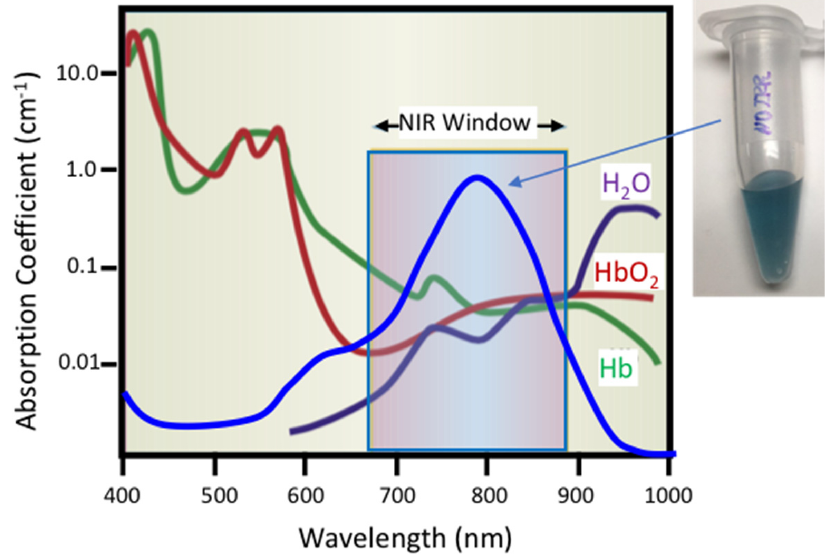
Figure 1. Schematic representation of optical adsorption of water (H 2 O), oxygenated hemoglobin (HbO 2 ), and hemoglobin (Hb) showing the near-infrared window (NIR) from 650–900 nm over which physiological materials do not adsorb significant fractions of incident light, adapted from [54], published by Nature, 2001. Hollow gold nanoshells (HGN) have a surface plasmon resonance determined by the HGN wall thickness and diameter that can be tuned to peak in the NIR Window. This causes HGN suspensions to appear dark blue to purple.